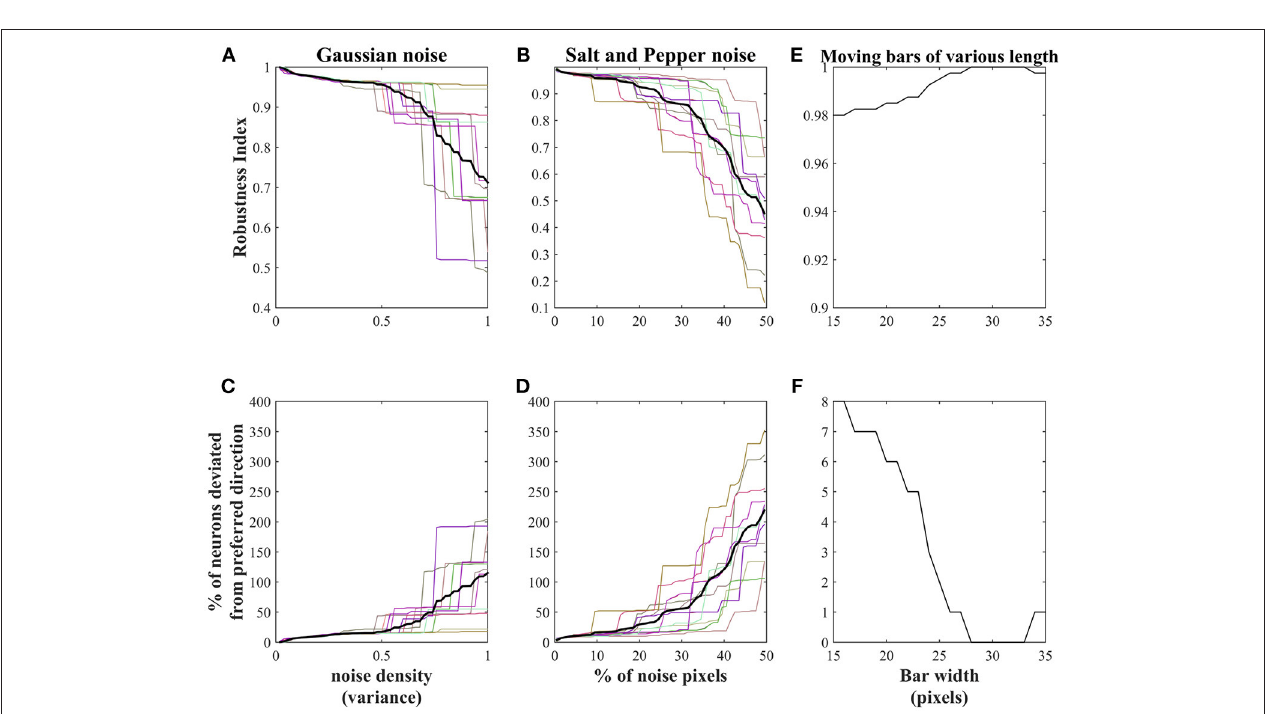
FIGURE 10 | Robustness of the trained network: NF1(20 × 20 units) trained using non-noisy moving bar is used to test the robustness of the proposed network. (A,B) represents the decrease in the robustness index (RI)of the network with an increase in the noise density. The thick black lines in (A,B) indicates the RI average across 20 trials. In the case of salt and pepper noise, RI reaches zero when 50% of the training set pixels were made noisy. Similar results can be seen with Gaussian noise with variance = 1. The network shows high tolerance: to the Gaussian noise with a variance of < 0.5 and to the salt and pepper noise whose density of < 0.3. (C,D) represents the number of pixels deviated from its preferred direction in relation to the noise density. (E) represents the robustness of the network to the varying bar length. RI reduced slightly with a change in the bar length. (F) shows the number of neurons deviated from their preferred directions to the change in bar length.